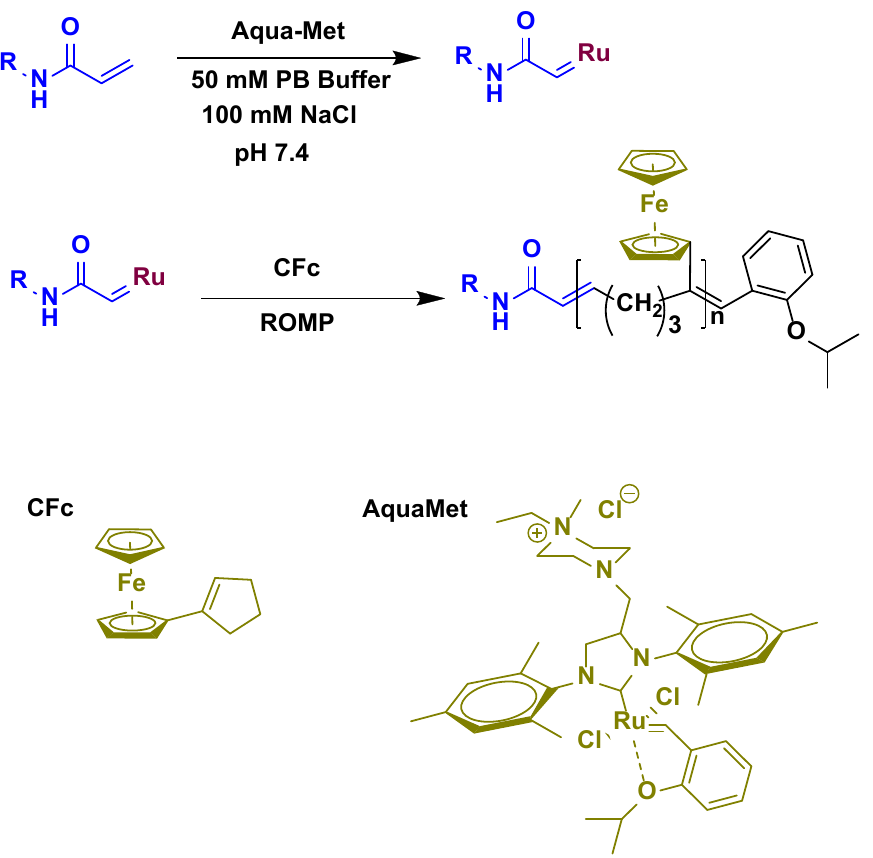
Scheme 2. Reaction mechanism of ring-opening polymerization (ROMP).